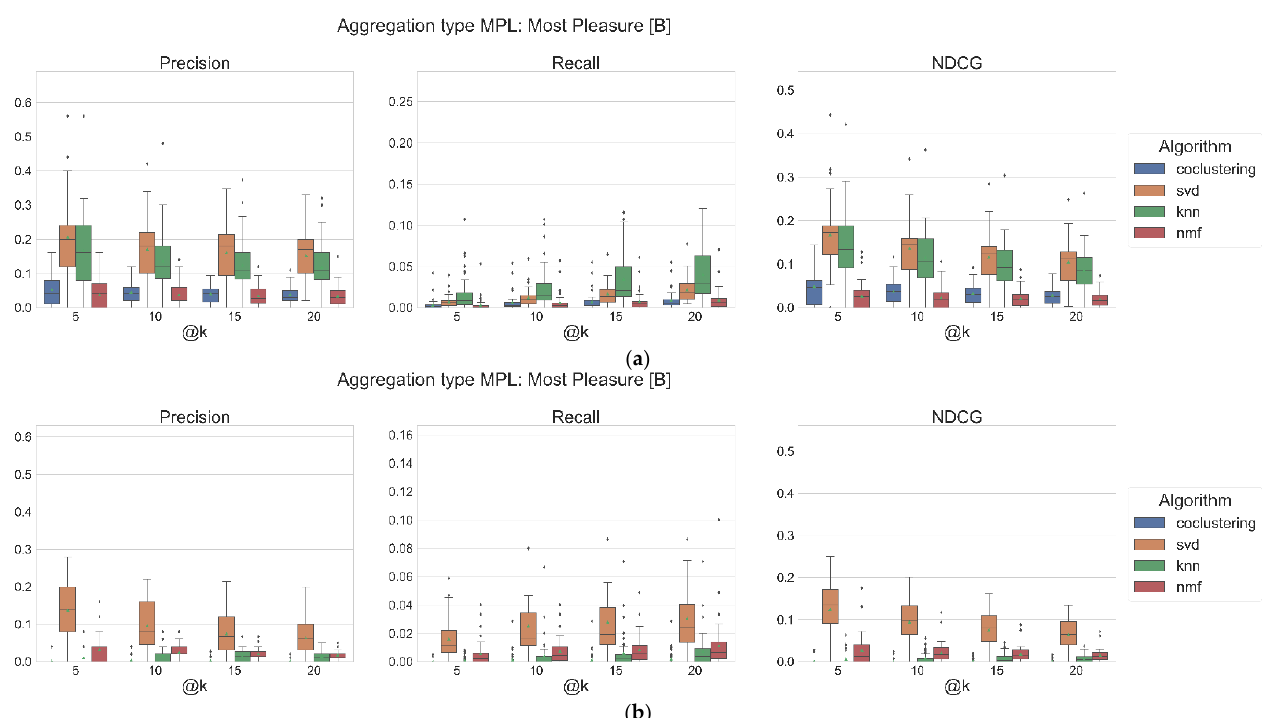
Figure 2. Box plots with the variation in group metrics for applied algorithms at different @k in both datasets: ( a ) LastFM- lk-spotify and ( b ) LFM-lb-small-spotify.